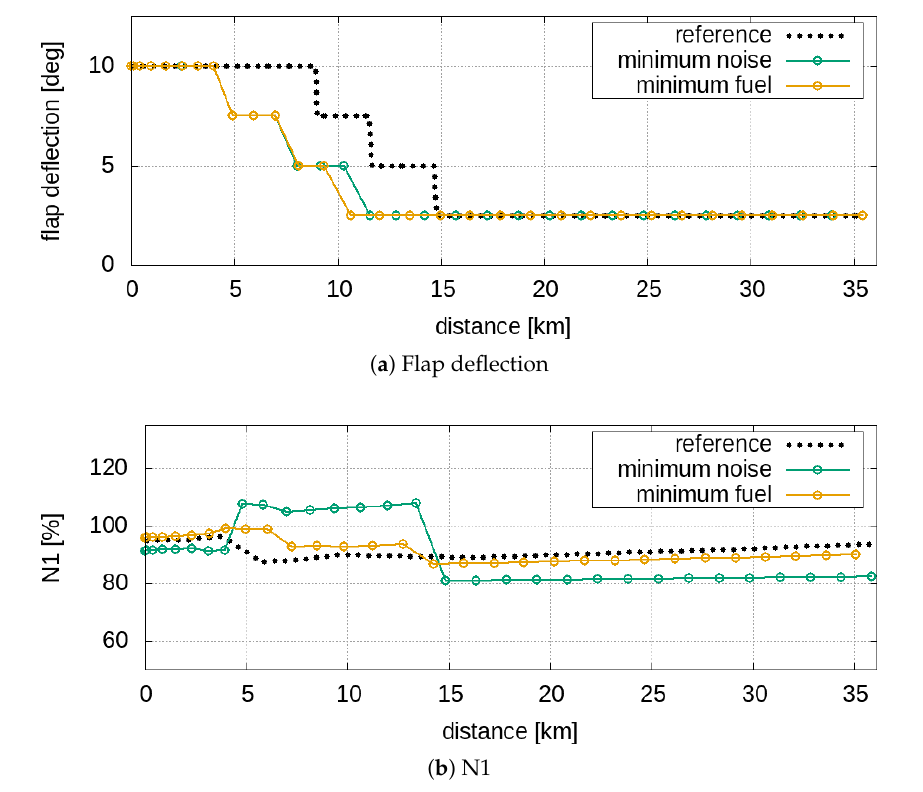
Figure 12. Takeoff manoeuvre for the twin-aisle aircraft. Procedural variables. ( a ) flap deflection, ( b ) N1.